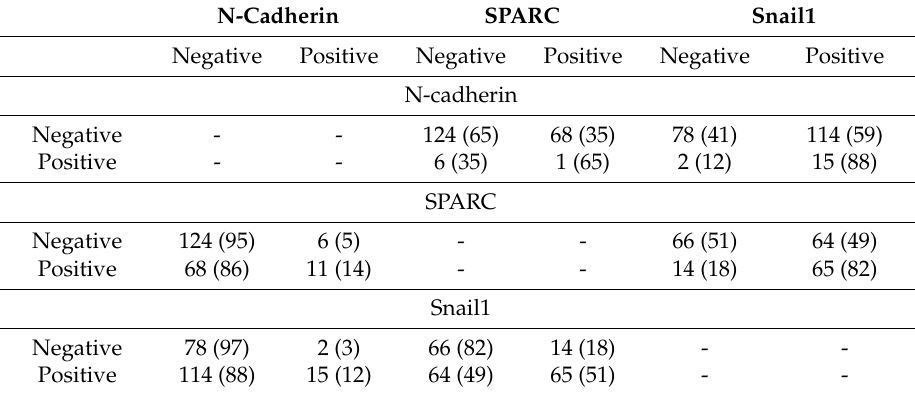
Table 2. Significant correlation between N-cadherin, Snail1, and secreted protein acidic and rich in cysteine (SPARC) expression; n